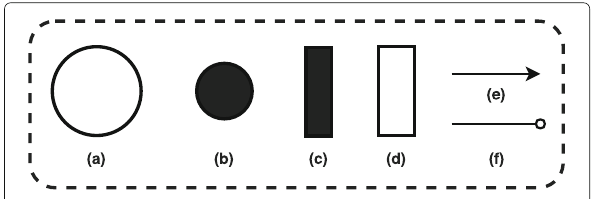
account both service requirements and resource